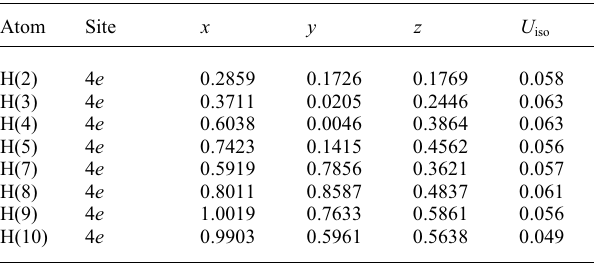
Table 2. Atomic coordinates and displacement parameters (in Å 2 )